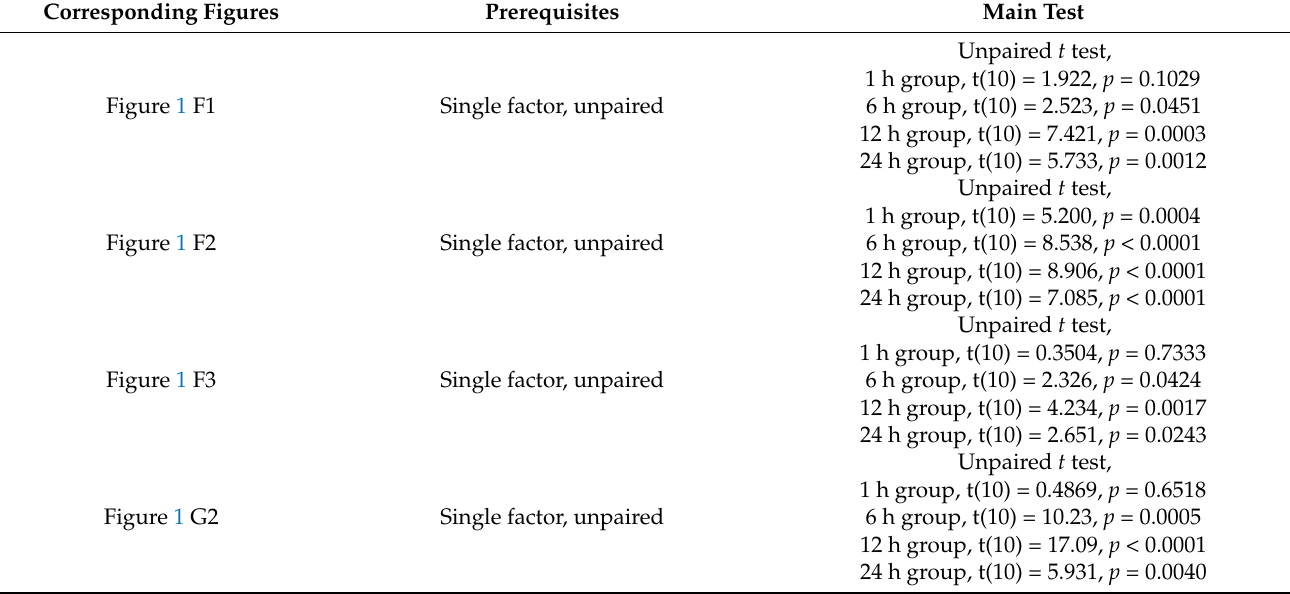
Table 1. Statistical tests used in the study.